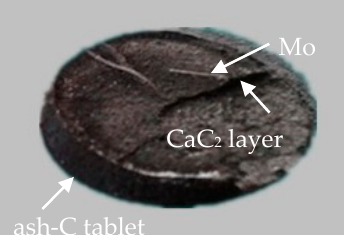
Figure 6. Diffusion models between CaO and ash–C distinguished by the Mo wires: ( a ) Sample a; ( b ) CaO diffuses into C; ( c ) C diffuses into CaO; ( d ) mutual diffusion of CaO and C.